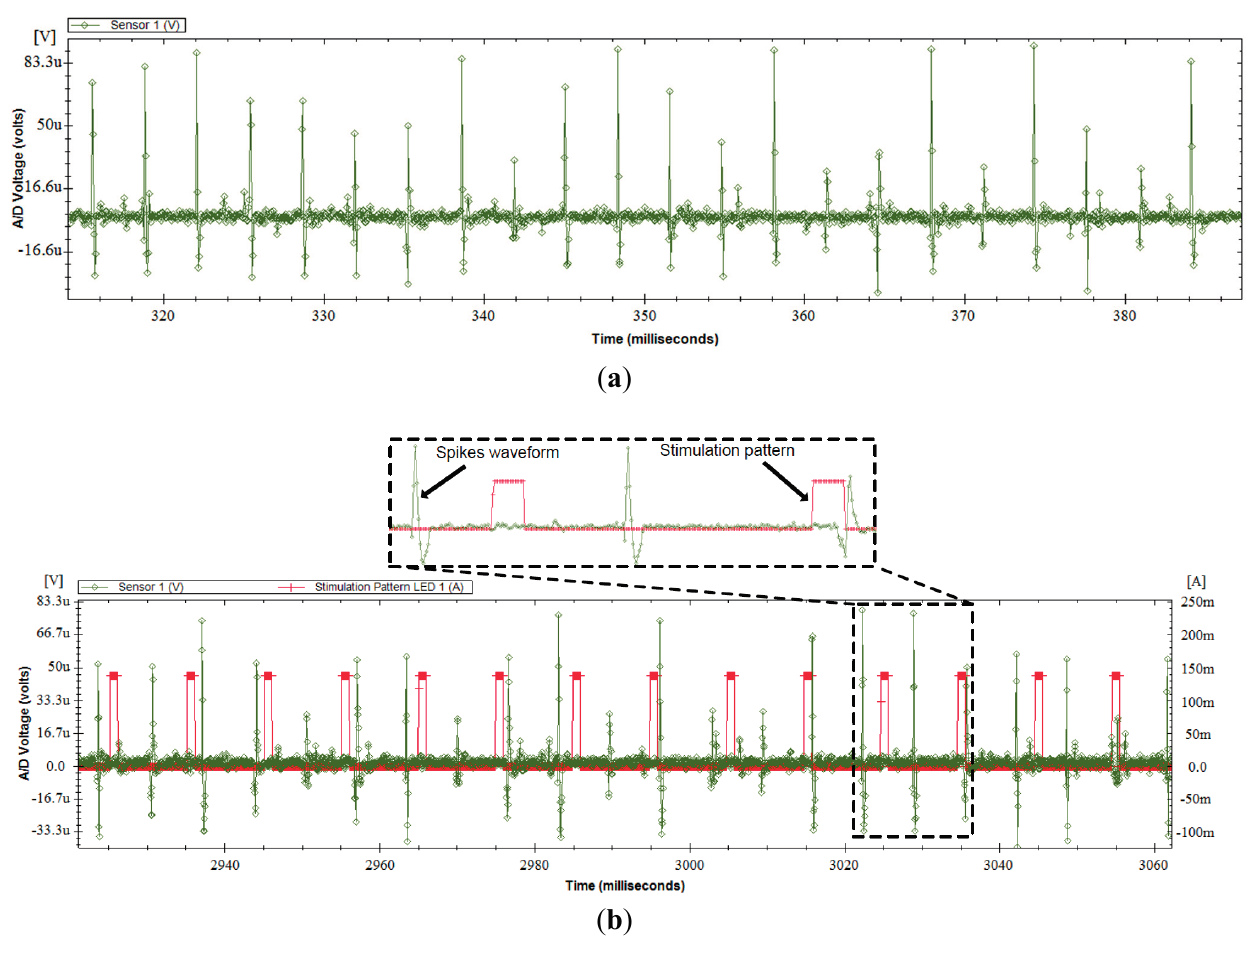
Figure 10. Measurements at the output of the whole data acquisition chain of the headstage fed with a synthetic neural signal input, while optical stimulation is enabled. ( a ) Acquired 150 µV peak-to-peak spike waveforms; ( b ) Output neuronal waveform and stimulation pattern both acquired using the whole data acquisition chain of the